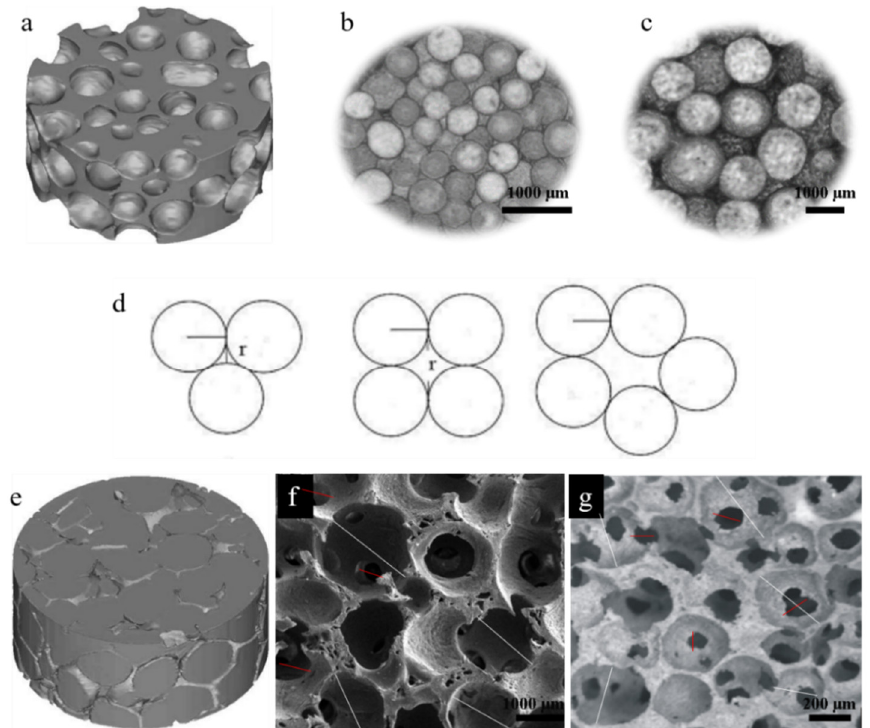
Figure 1. 3D reconstruction using Micro-CT and showing macropore of HASAs and HAPPs.The stellate-shape macropore of HASAs ( a ). The pore size was decided by the size of HA spheres (( b ): S-HASAs; ( c ): L-HASAs) and the arrangement of the spheres ( d ). The spherical-shape macropore of HAPPs ( e ). SEM showed the macropores and interconnective pores of L-HAPPs ( f ) and S-HAPPs ( g ).